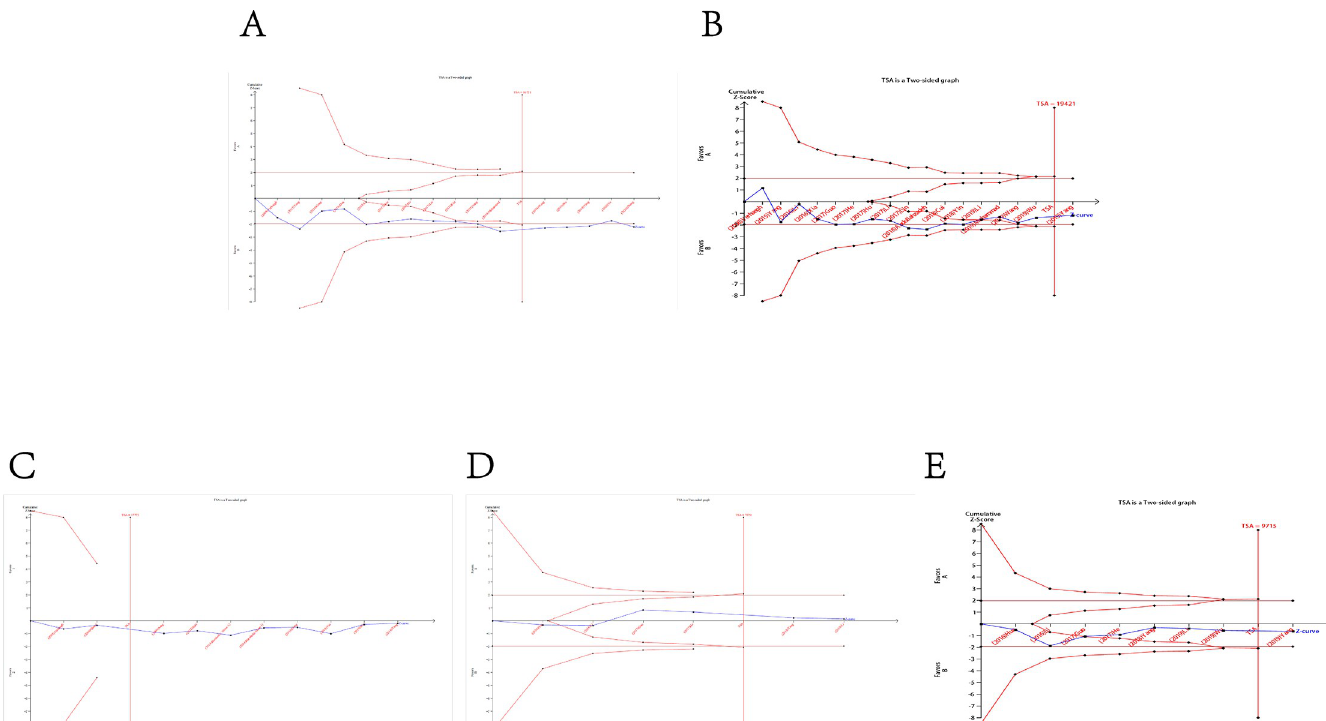
Fig 9. Trial sequential analysis of the association between H19 polymorphisms and the susceptibility to cancer. The required information size was calculated based on a 2-sided α = 5%, β = 15% (power 85%), and a relative risk reduction of 20%. A: rs2839698; B: rs217727; C: rs2107425; D: rs2735971; E: rs3024270.